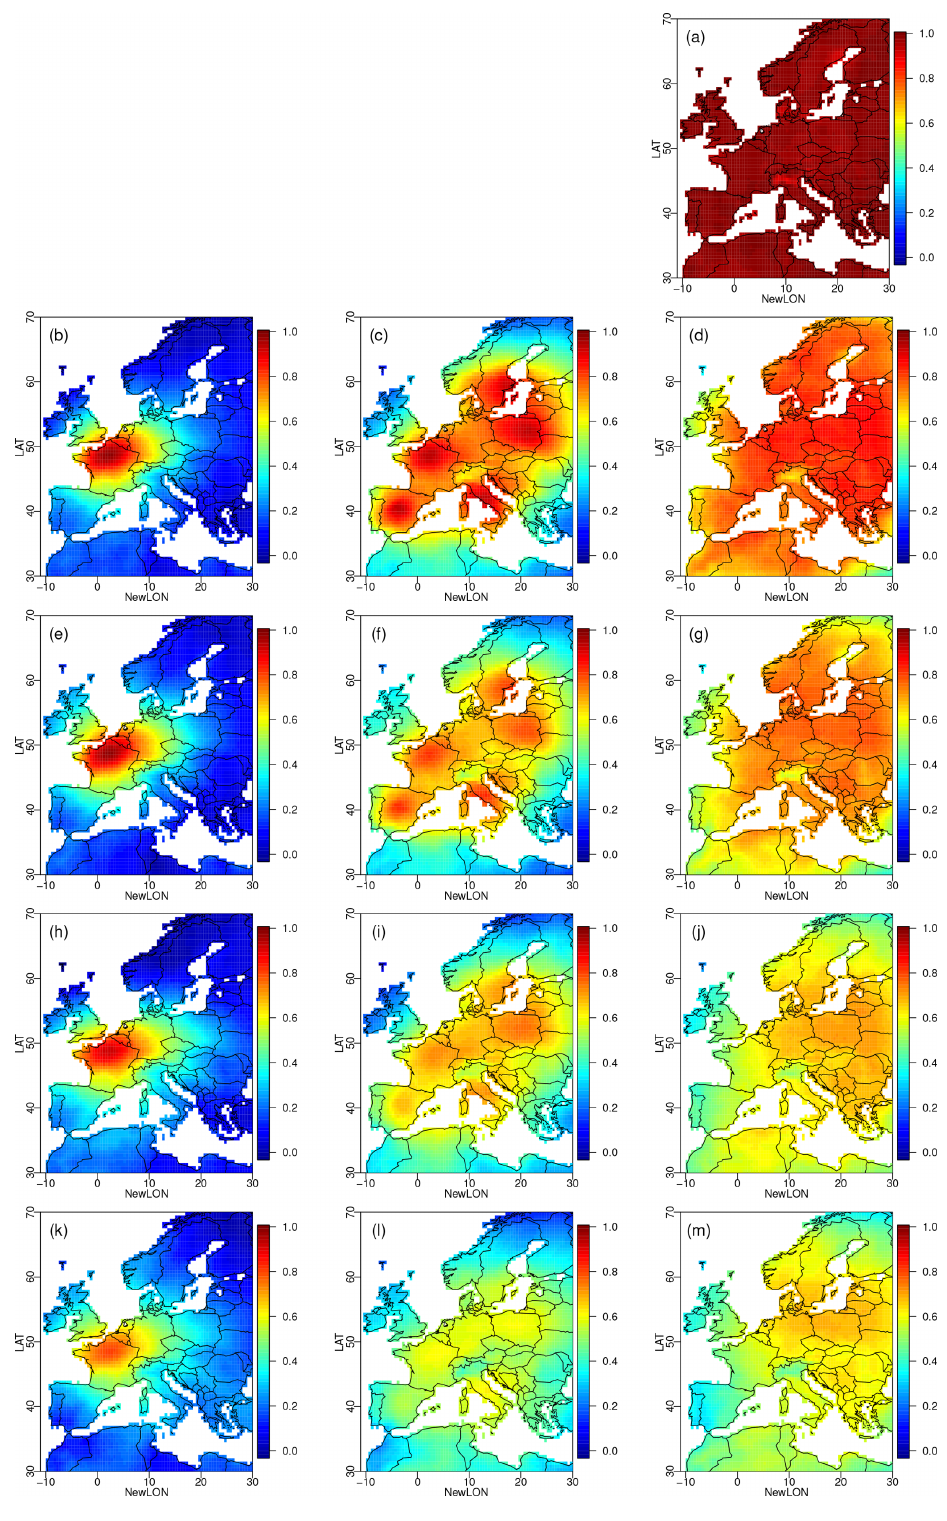
Figure 4. Maps of Spearman (rank) correlations calculated for each grid point in winter over 1979–2016 between the initial climate model temperature simulations and their corrections by (a) 1d-BC, (b) R.1.1.0, (c) R.5.1.0, (d) R.100.1.0, (e) R.1.2.0, (f) R.5.2.0, (g) R.100.2.0,